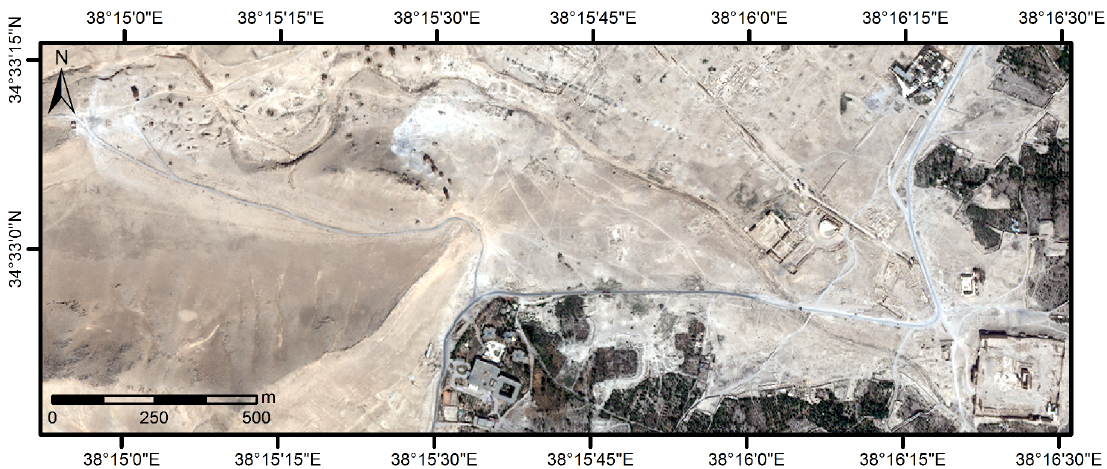
Figure 4. Subset of the WorldView-2 image acquired on the 27 August 2015 ( c (cid:13) European Space Imaging/DigitalGlobe).